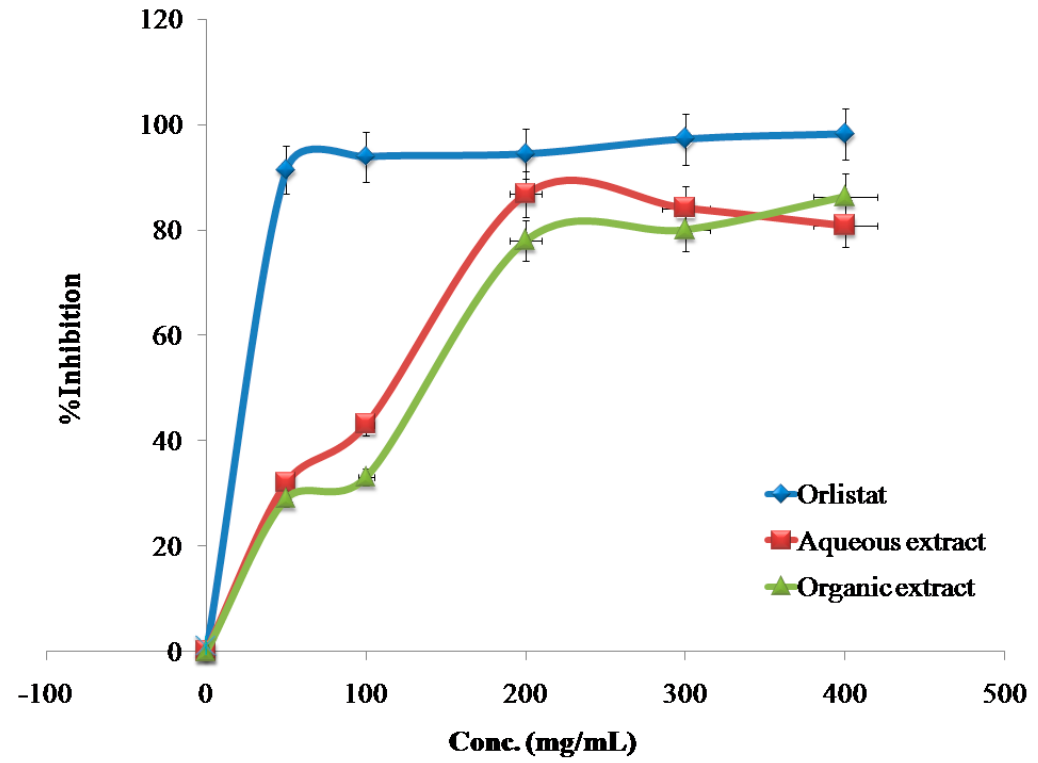
Figure 8. The inhibitory effects of the aqueous and organic extracts of R. officinalis and Orlistat on the activity of porcine pancreatic lipase.